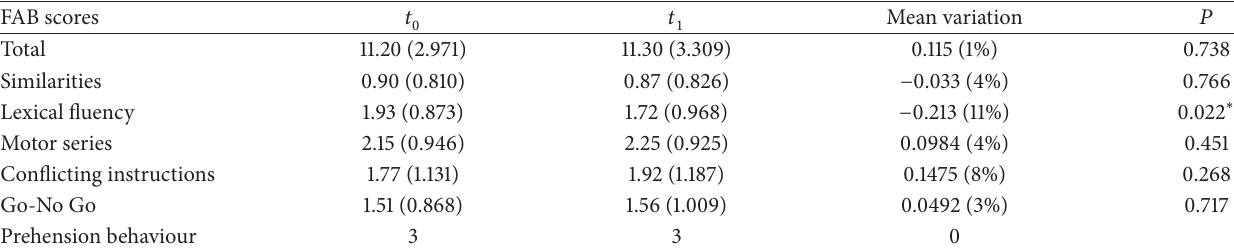
Table 3: Frontal assessment battery scores’ variation.